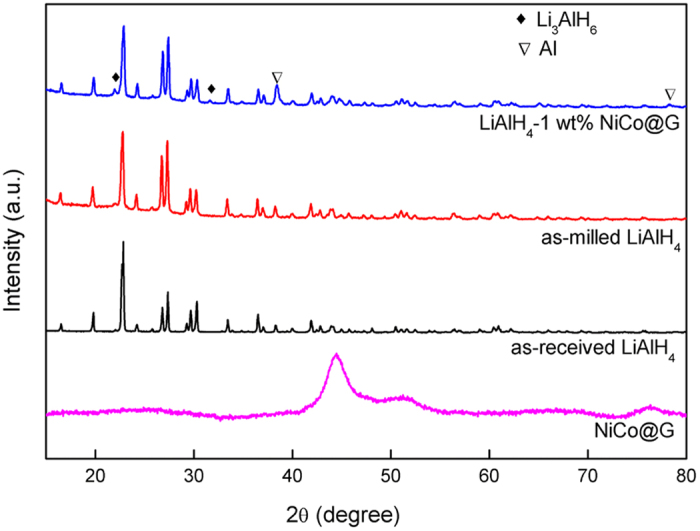
XRD patterns of NiCo@G, as-received LiAlH4, as-milled LiAlH4 and LiAlH4-1 wt% NiCo@G.